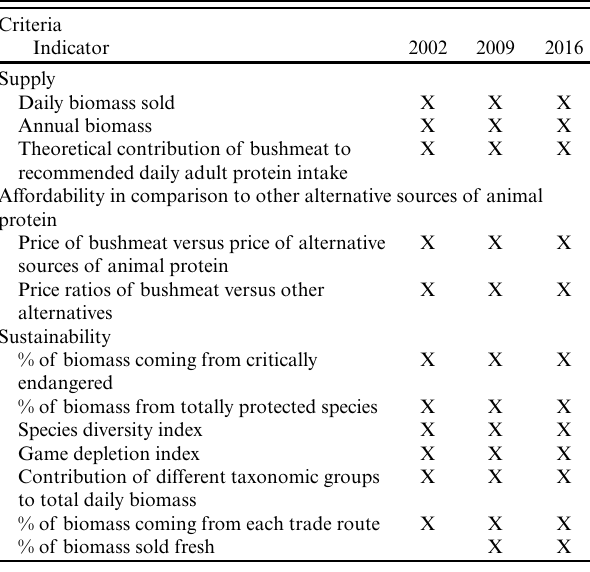
Table 1 . Criteria and indicators used in this study. Criteria